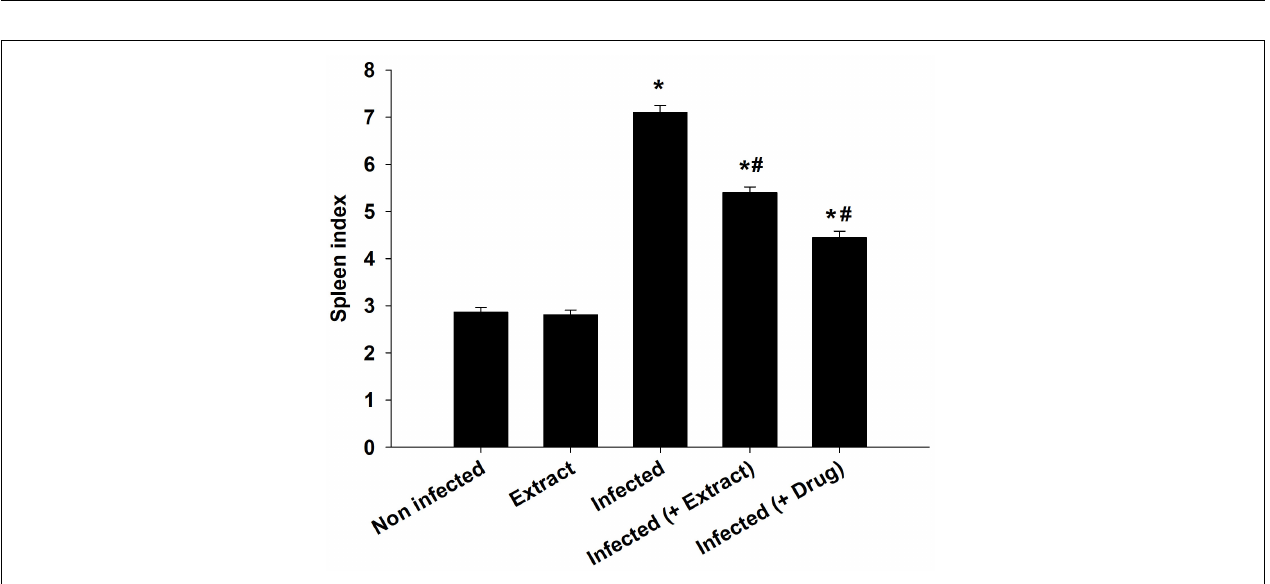
Frontiers in Microbiology |